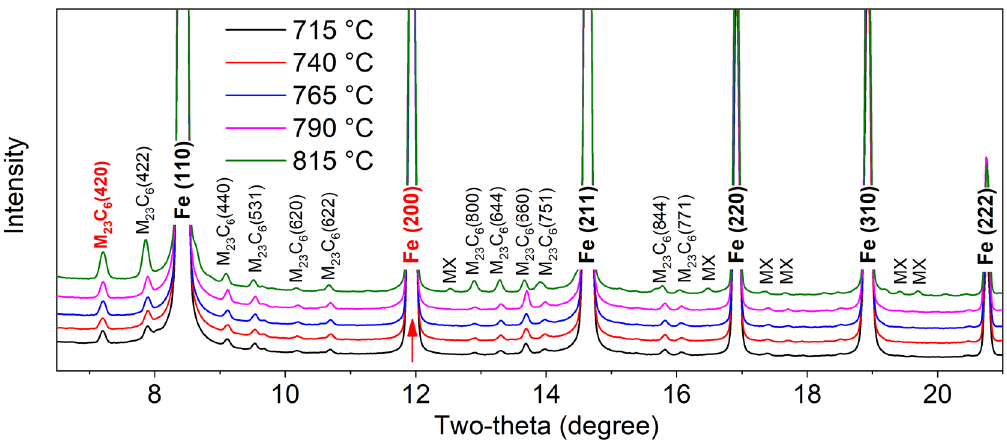
Figure 3. Synchrotron radiation X-ray diffraction (SR-XRD) spectrum of the P92 heat-resistant steel tempered at different temperatures.